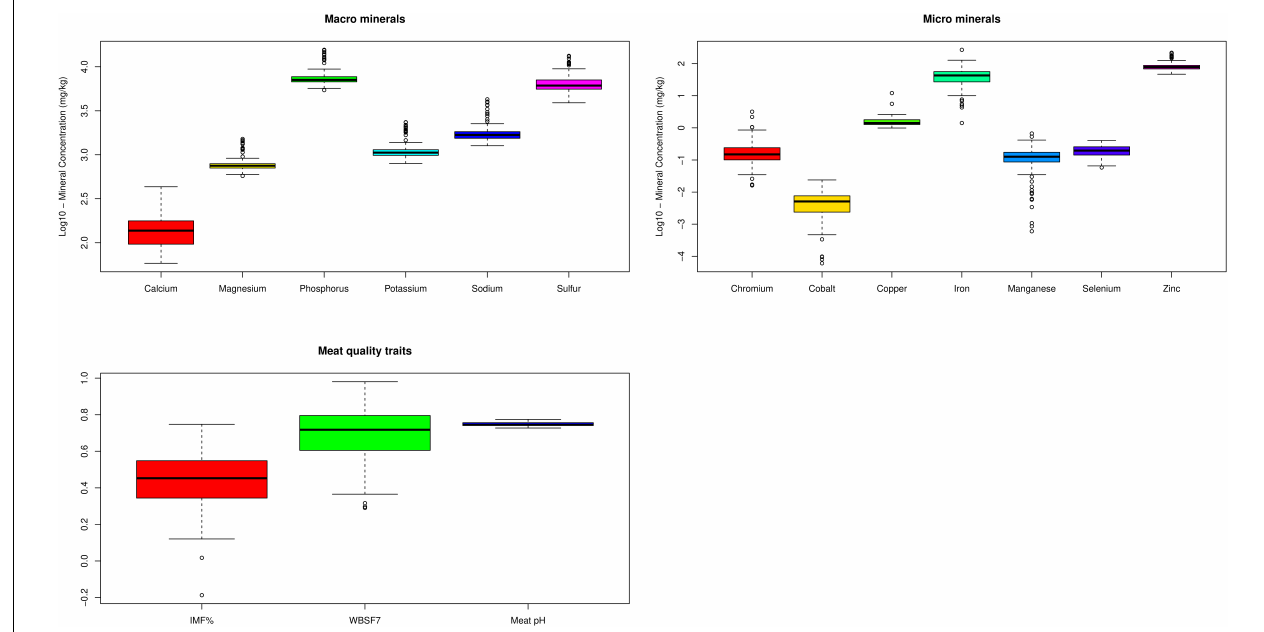
FIGURE 2 | Box plot of mineral concentration (macro and micro) and meat quality traits. IMF% – Percentage of intramuscular fat content; WBSF7 – Warner-Bratzler Shear Force after 7 days of meat aging; The data are in log10